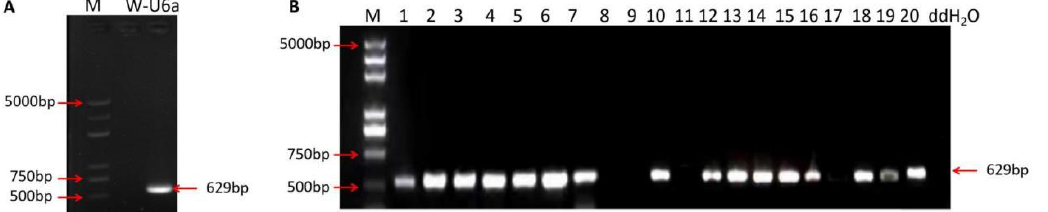
Figure 1. Location of sgRNA in the Wx gene and designed primers for amplification. ( A ): Wx gene partial sequence showing target positions and primer sequences; purple nucleotides: Upstream and downstream primers; Red Box: sgRNA sequences; black underline nucleotides: protospacer adjacent motif (PAM) region; ( B ): Sequencing peak map of sgRNA.